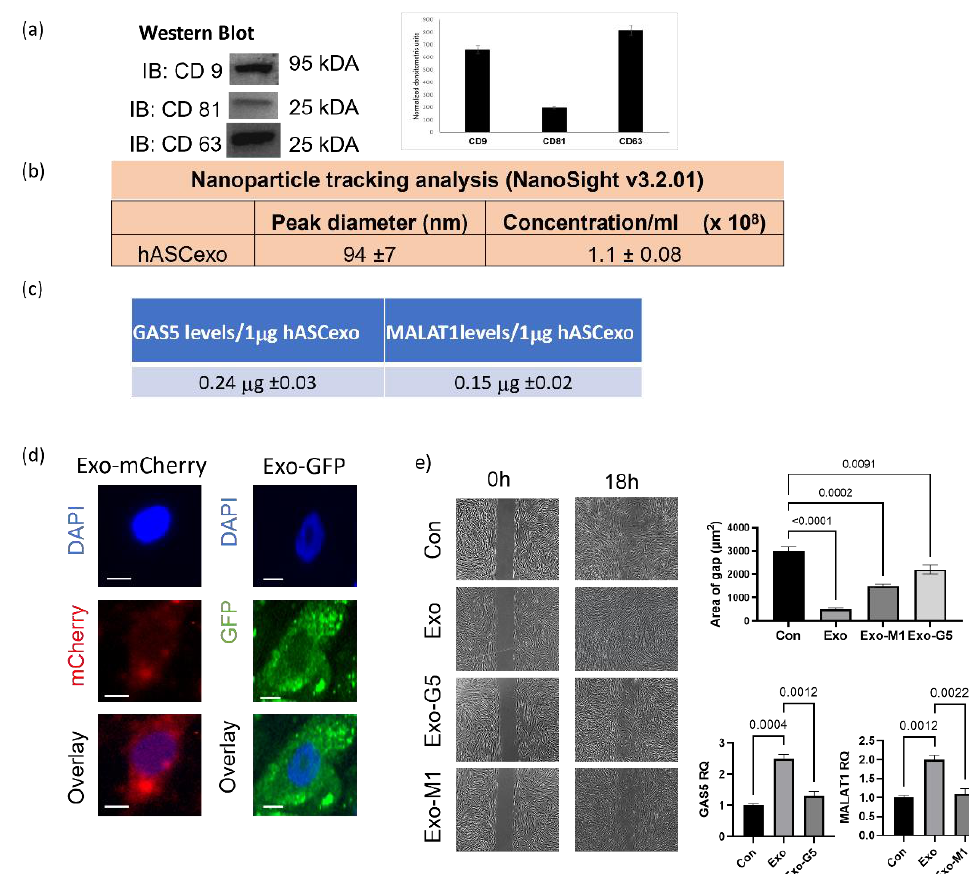
Figure 1. Exosomes isolated from hASCs were verified by ( a ) western blot for hASC exosomal tetraspanin markers using antibodies against CD9, CD63, and CD81. The bands are representative of results obtained from experiments repeated five times. The graph represents ±SEM densitometric units. ( b ) The size and purity od hASC exosomes were evaluated using NanoSight v3.2.01 and ( c ) levels of long noncoding RNAs GAS5 and MALAT1 by absolute quantification by qPCR per 1 µg of exosomes across batches. ( d ) 1µg of mCherry or GFP overexpression plasmids were transfected into hASCs and exosomes were isolated from conditioned media. HDF cells were treated with 1 µg of exosomes and imaged using the Keyence microscope after 24 h showing uptake of hASC exosomes carrying mCherry or GFP (scale bar 20 µm, n = 3). ( e ) HDF cells were grown in a 35mm plate with Ibidi μ -inserts to generate consistent gaps. Inserts were removed and HDF cells were treated with exosomes (Exo) or exosomes depleted of GAS5 (Exo-G5) or depleted of MALAT1 (Exo-M1). Gap was imaged at time 0 and re-imaged after 18 hours. Wound gap was measured using Image J and area was calculated in µm 2 ( n = 3). Statistical analysis was performed by one-way ANOVA and significant p -values (<0.05) are indicated on graph.